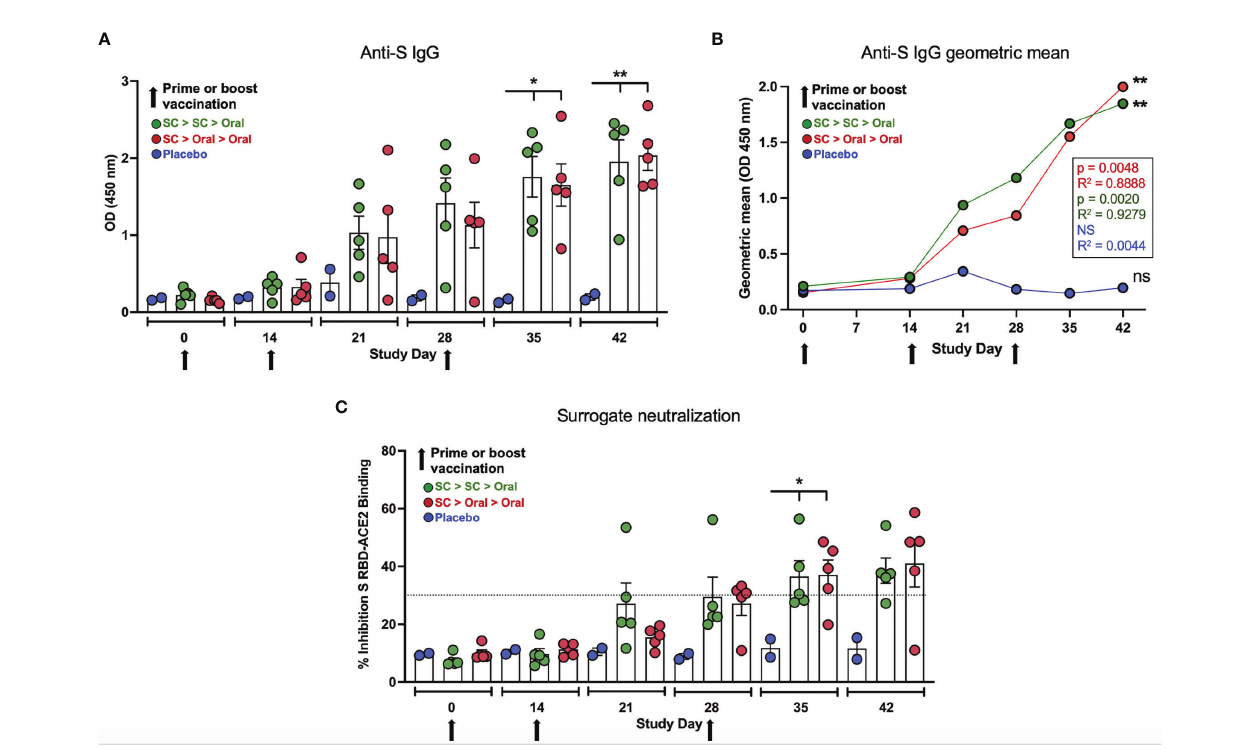
FIGURE 3 | Anti-spike (S) IgG and neutralizing capability. (A) Anti-S IgG levels (ELISA; OD 450 nm) at Days 0, 14, 21, 28, 35 and 42 are shown for placebo, SC > SC > Oral and SC > Oral > Oral NHP groups. Anti-S IgG levels in both groups of vaccinated NHP were signi fi cantly higher than placebo control on Days 35 and 42 (Day 35 p = 0.0134 and = 0.0192; and Day 42 p = 0.0046 and = 0.0035 for SC > SC > Oral and SC > Oral > Oral versus control, respectively). (B) The geometric means for anti-S IgG for each group are shown. Both vaccinated groups were signi fi cantly higher than the placebo controls; p and R 2 values are shown. (C) Percent inhibition in the surrogate assay where ≥ 30% (dashed line) correlates with live virus neutralization. Inhibition was signi fi cantly greater for vaccinated groups on Day 35 - p = 0.0444 and = 0.0404 - with a trend to greater inhibition on Day 42 - p = 0.0732 and = 0.0520 – both SC > SC > Oral and SC > Oral > Oral, respectively. Statistical analysis performed using one-way ANOVA with Dunnett ’ s post-hoc comparison of vaccinated groups with placebo; where *p < 0.05, **p ≤ 0.01, and ns, not signi fi cant. Data graphed as the mean and